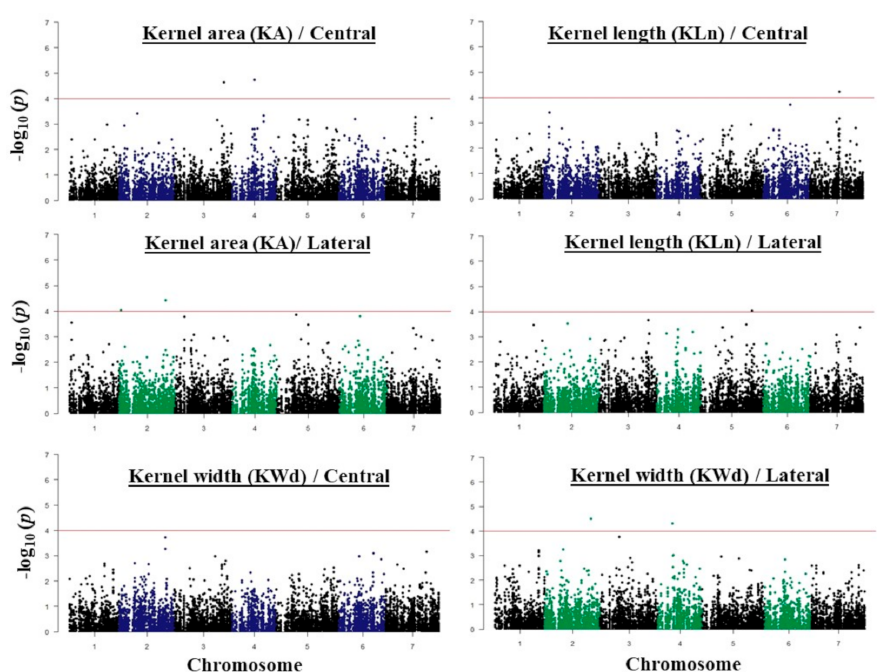
Figure 5. Manhattan plots of GWAS conducted on KA, KWd, and KLn, for central spikelets and lateral